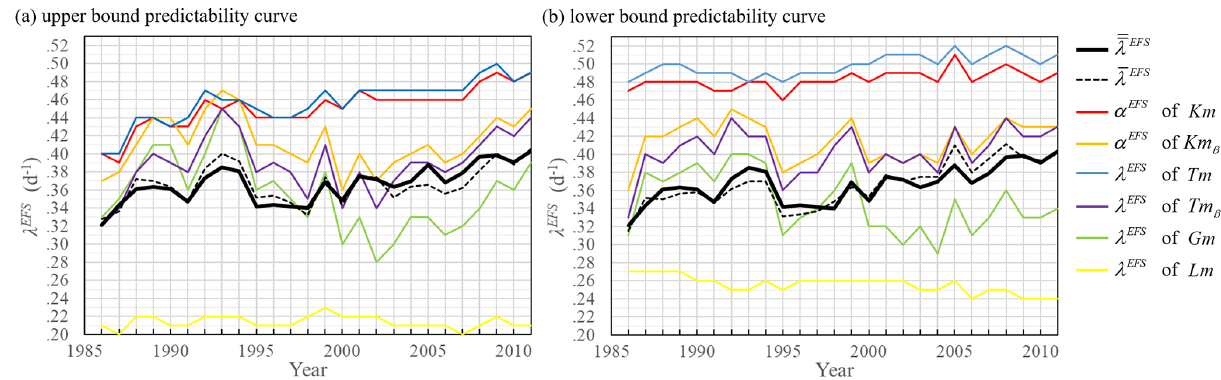
EFS (black, solid), average values